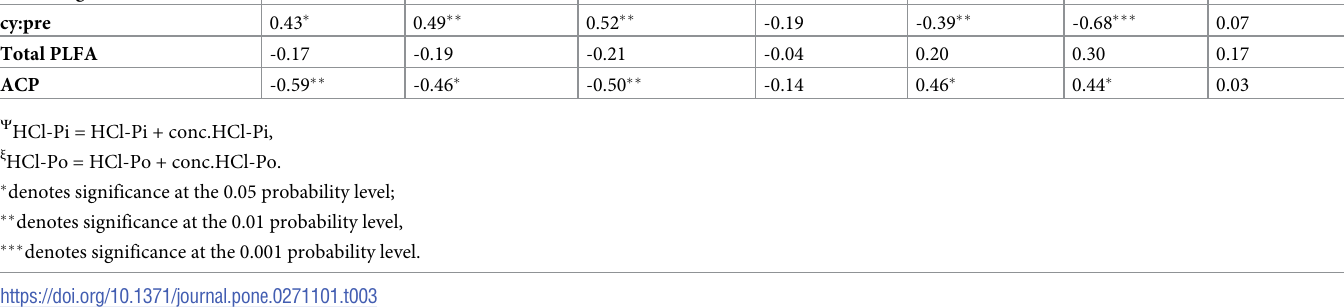
Table 3. Spearman rank correlation coefficients between the soil P fractions (mg/kg) and the biomarker-PLFAs (%) measured from soil samples (n = 27).